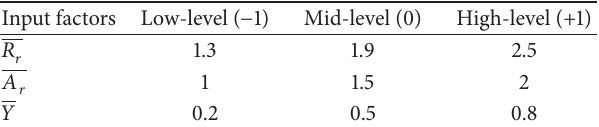
Table 1: Matrix of the 3 3